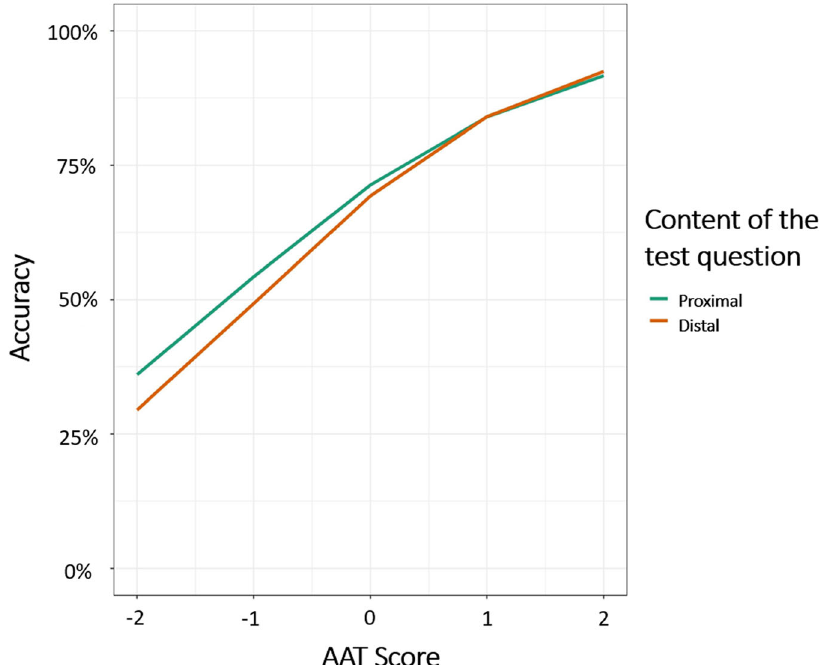
Fig. 2 Results of study 1. Accuracy as a function of AAT (in standard deviation scores) and distance of the test question.